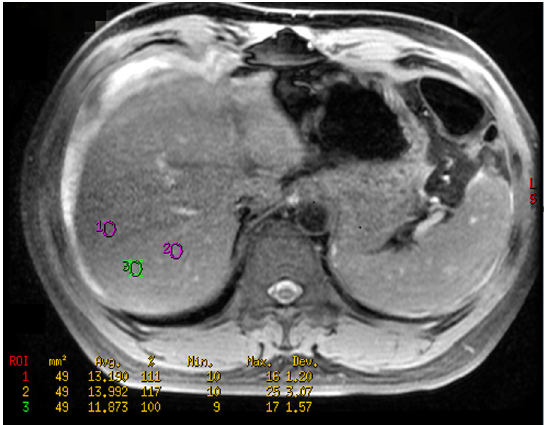
Fig 1. The outlines of regions of interest to obtain the liver lobe based T2 * values. In a 51-year-old male with Child-Pugh Class C of liver cirrhosis, three regions of interest are randomly drawn in right liver lobe in a representative axial plane by the software to obtain the T 2 * value of this liver lobe, and the similar methods are used to obtain the T 2 * values of the other liver